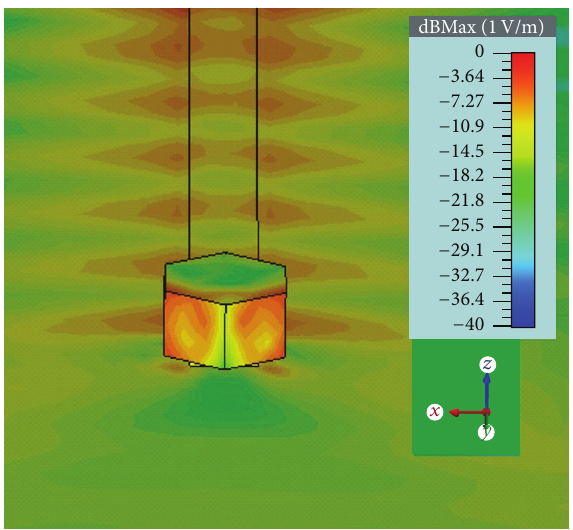
Figure 7: Magnitude of 𝐸 -field distribution at 193.5 THz with HE 20𝛿 mode.